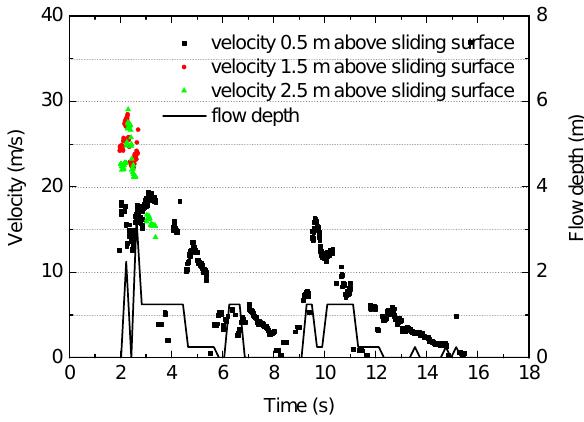
Fig. 11. Avalanche 3: flow depth and internal velocities measured at the pylon, close to cavern C. The avalanche was characterized by a low density, diluted flow moving up to 30ms − 1 (dots). The flow depth was small. Undulations in velocity and flow depth indicate that the flow had two